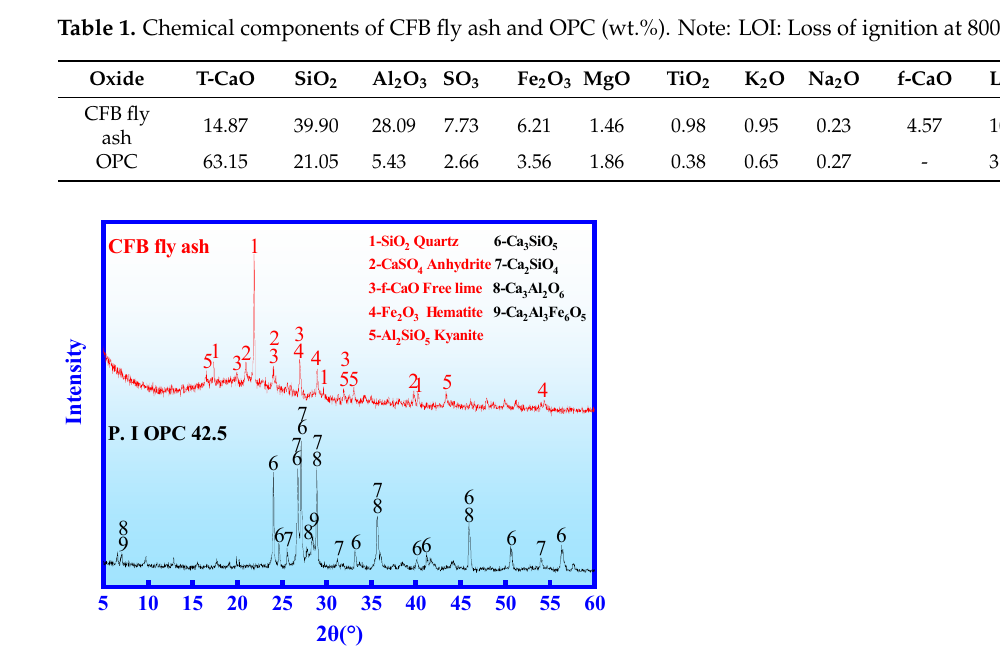
Figure 3. Microscopic morphology of (a) CFB fly ash and (b) OPC 42.5. 2.2. Proportional design of CMM The original CFB fly ash is dried at 105 °C for 24 h. Then, the CFB fly ash is ground on a mechanical grinding machine for 15 min. CMM are prepared by CFB fly ash and OPC. Seven groups of CMM with various mass ratios of T ‐ CaO/(SiO 2 +Al 2 O 3 ) (Ca/(Si+Al)) were prepared. As shown in Table 2, the design of CMM0~ CMM5, and the corresponding chemical components is shown in Table 3. It is apparent from Tables 2 and 3 that the mass ratio of Ca/(Si+ Al) decreases from 2.38 to 0.83 with the increase of CFB fly ash from 0 to 50 wt.%, while f ‐ CaO mass ratio increases gradually. Table 2. Designed proportion of different CMM. Mix Sample CFB Fly Ash (wt.%)